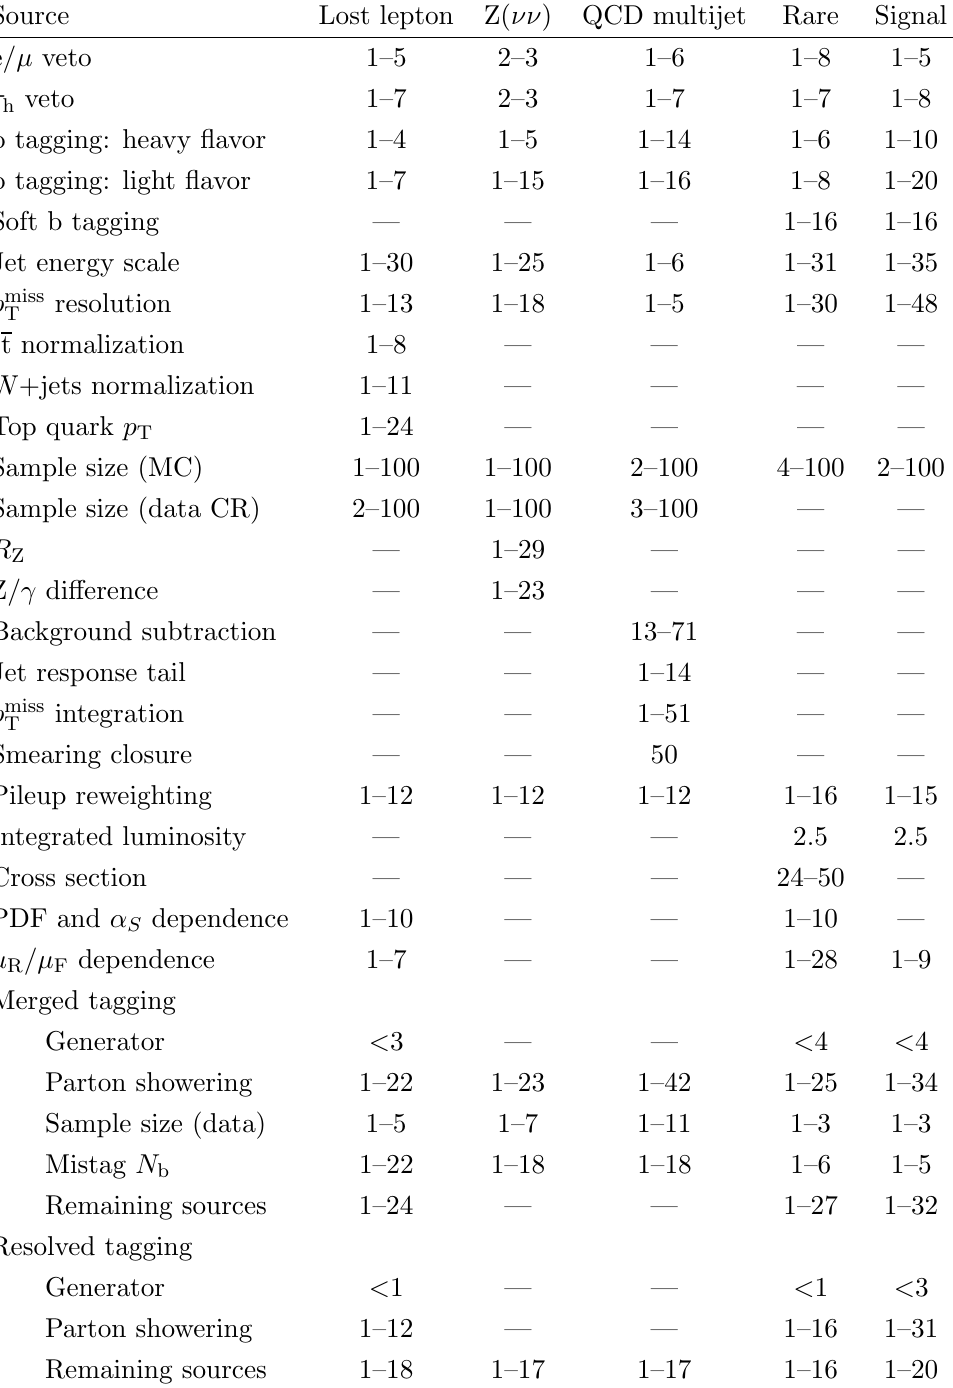
Table 4 . Range of systematic uncertainties [%] in the prediction across the di(cid:11)erent search regions. \Rare" column includes diboson and ttZ processes. \Signal" column shows the range of systematic uncertainties representative of the full set of models shown in (cid:12)gure